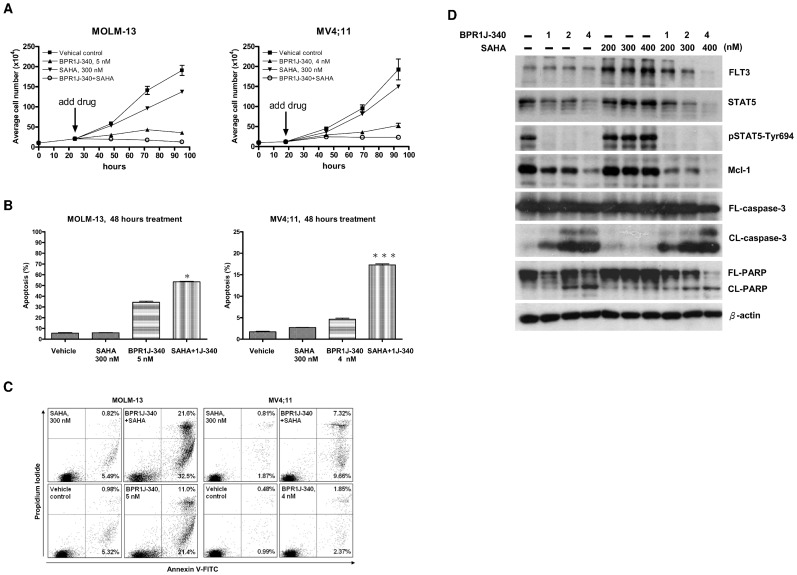
The effect of BPR1J-340 and SAHA versus drug combination on AML FLT3-ITD+ cells.MOLM-13 or MV4;11 cells were seeded at an initial concentration of 1×105 cell mL−1 for 24 hours and then treated with BPR-1J340 either alone or in combination with SAHA in the indicated concentrations. (A) Viable cells were counted after staining with trypan blue dye at indicated time point (B) At 48-hours after treatment, cells were stained with FITC-labeled annexin V and propidium iodide and percentages of apoptotic cells were analyzed by flow cytometry. (C) The representative flow cytometry histograms of assays of annexin positive apoptotic cells at 48 hours drug treatment (D) MOLM-13 cells were treated with drugs for 20 hours, and then followed by Western blot analysis to assess changes in protein levels with the indicated antibodies. Statistical analysis was performed using Student's t-test. *Indicates significant difference compared to vehicle control (* p<0.05, * * * p<0.01). Data shown are representative of multiple independent experiments.